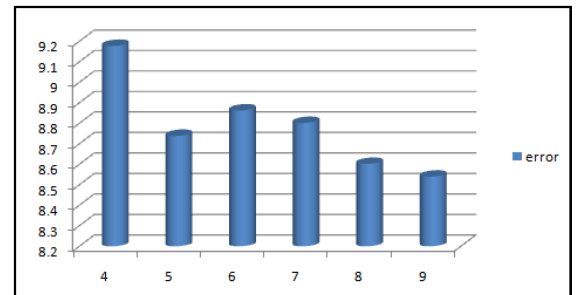
. Figure 5. RTK GPS from known GPS Station (2 minutes)